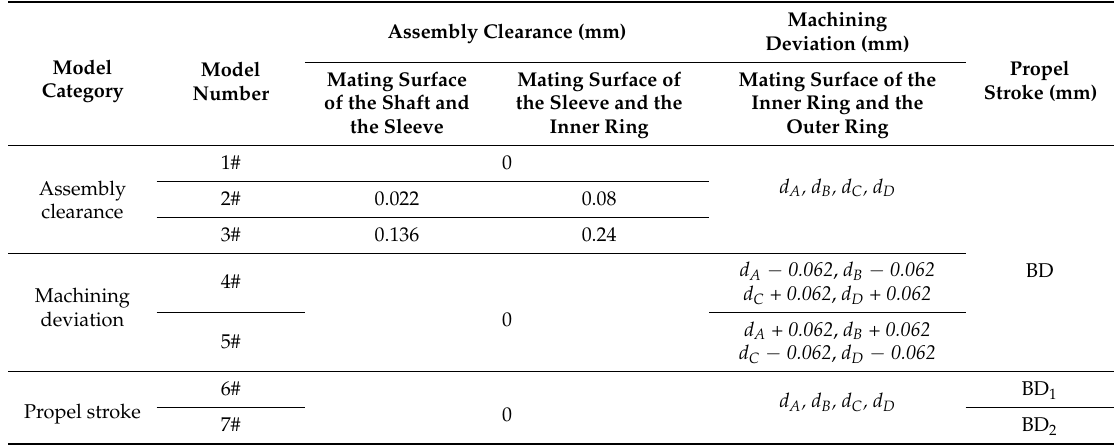
Table 1. Dimensions of mating